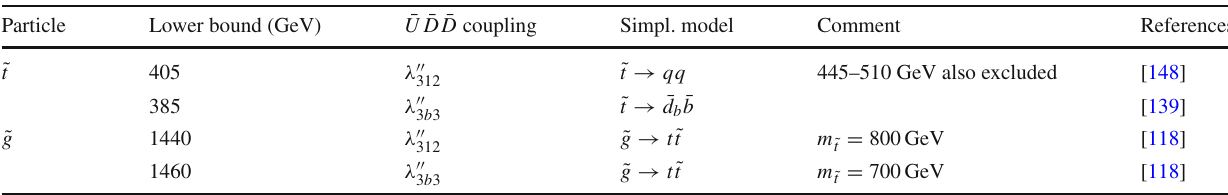
Table 10 Lower mass bounds for the case of a stop LSP discussed in Sect. 5.2. Here b = 1 , 2 Particle Lower bound (GeV) Simpl.